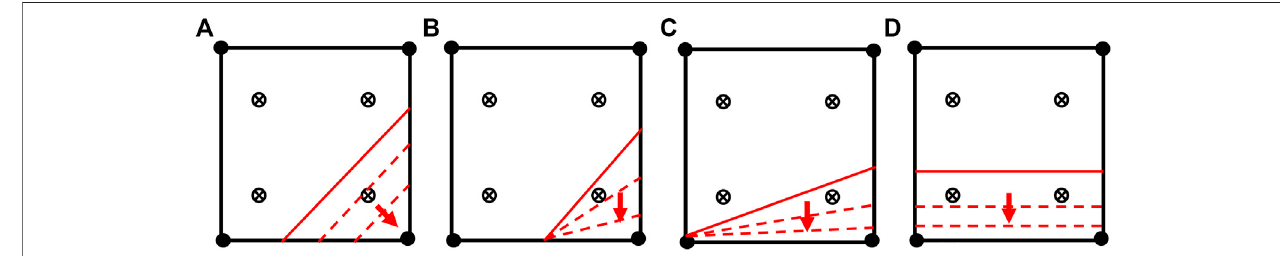
FIGURE5| Diagramoftypicalpartitionpatternsofdiscontinuousinterface: (A) Interfacecutsadjacentsidesofelement,cuttingangle fi xedat45 ° ; (B) Interfacecuts adjacentsidesofelement, intersecting withone elementside fi xed at midpoint; (C) Interface cuts twoopposite sidesof element, with distance between one intersection point and one element node fi xed at 0.01% of element side length; (D) Interface is parallel to one side of element.